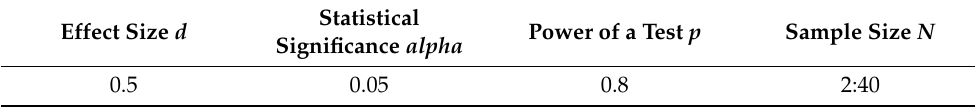
Table 1. Chosen requirements for population